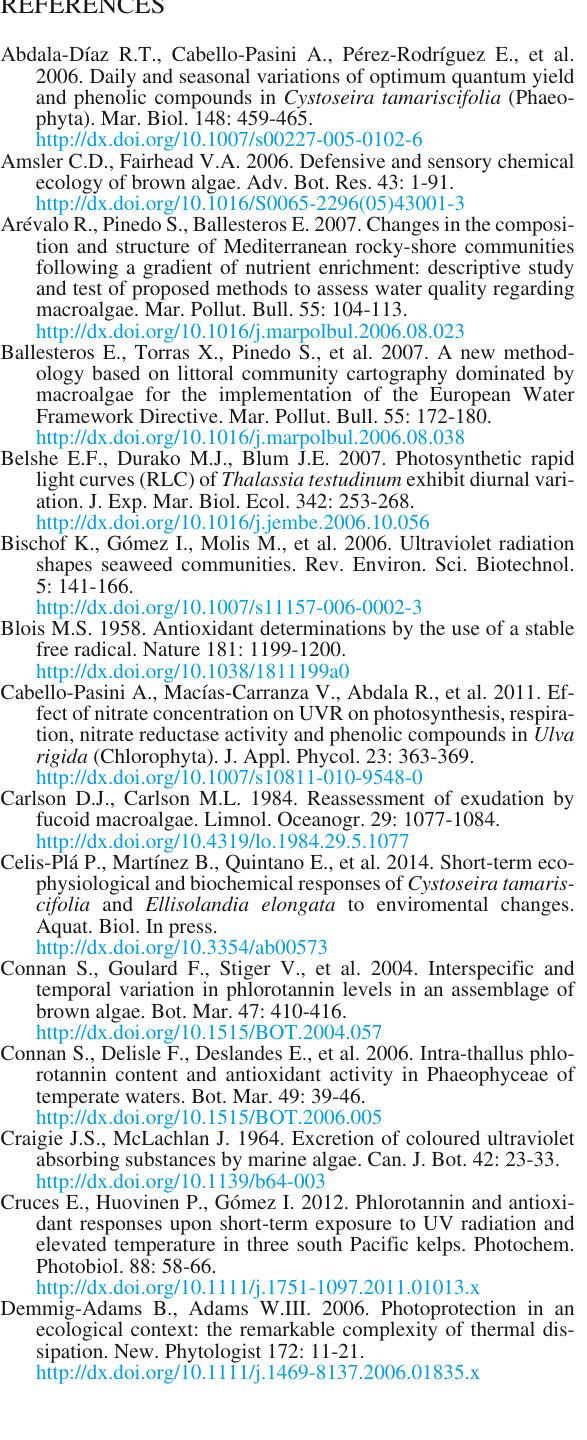
Figueroa F.L., Gómez I. 2001. Photoacclimation to solar UV radia- tion in red macroalgae. J. Appl. Phycology. 13: 235-248.